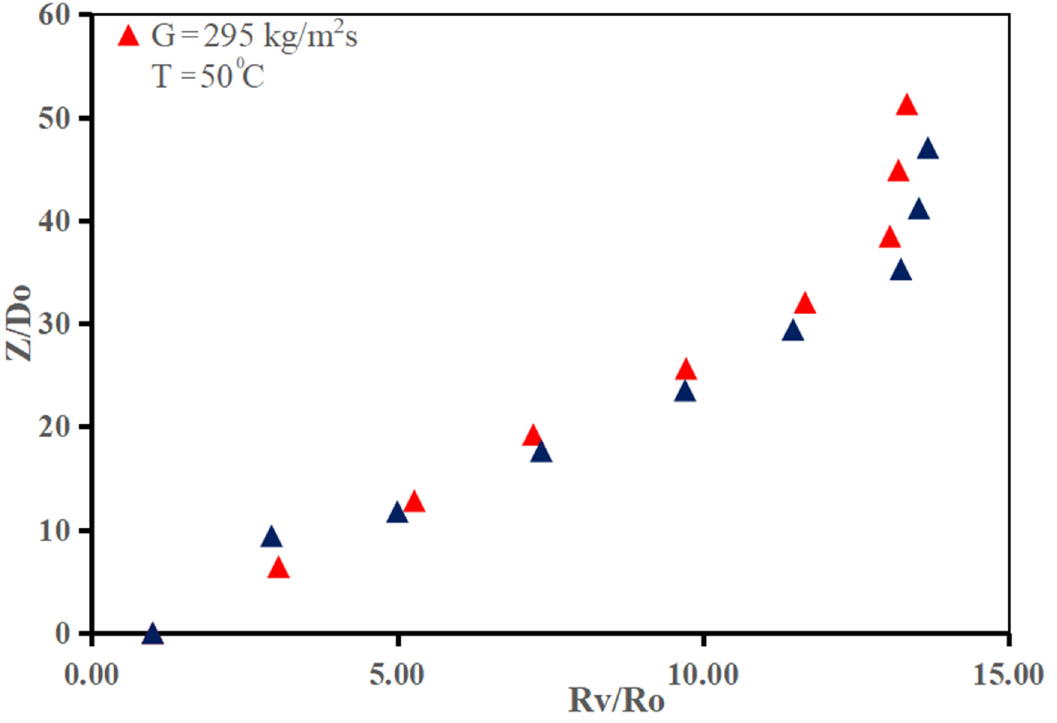
Figure 10. Normalized radial growth of a thermal liquid jet compared to the normalized vertical distance. cal